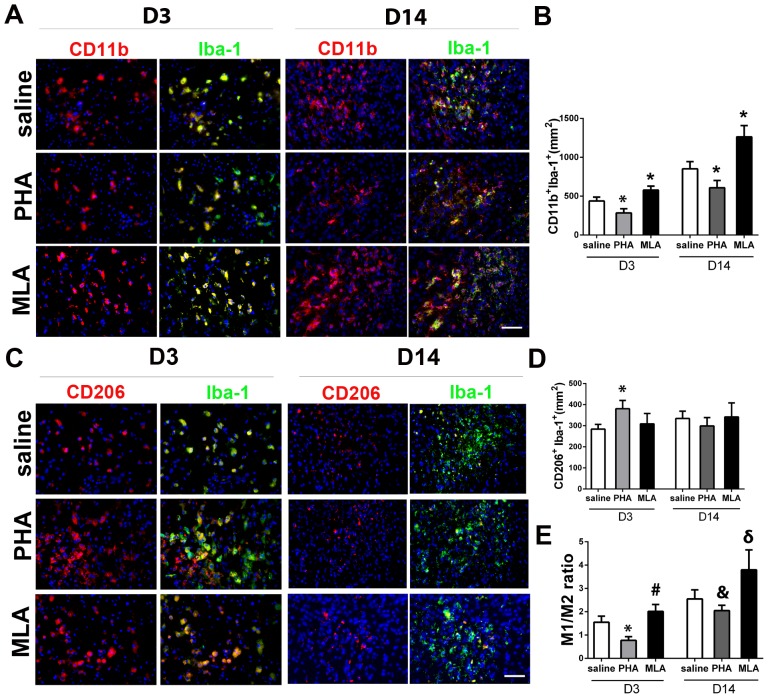
PHA decreased pro-inflammatory microglia/macrophages (M1).A: Representative images of M1 (CD11b+Iba-1+) staining. The nuclei were counterstained with DAPI. Scale bar: 50 µm. B: Quantification of M1 in the peri-infarct region. *: p<0.001, vs. saline group at corresponding time points. C: Representative images of M2 (CD206+Iba-1+) staining. The nuclei were counterstained with DAPI. Scale bar: 50 µm. D: Quantification of M2 microglia/macrophages in the peri-infarct region. *: p<0.001 vs. saline group on D3 after pMCAO. E: The ratios of M1 and M2 cells. *: p<0.001, #: p = 0.018 vs. saline group 3 days after pMCAO; and &: p = 0.015, δ: p = 0.009 vs. saline group 14 days after pMCAO.